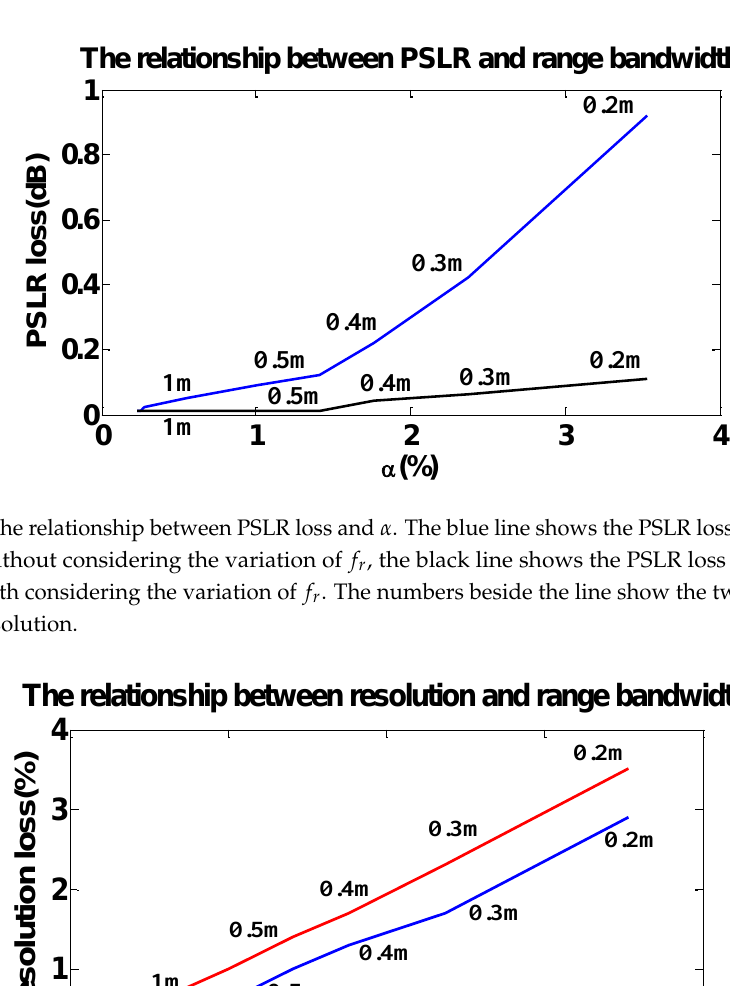
Figure 13. The relationship between resolution loss and α . The blue line shows the resolution loss in the azimuth direction without considering the variation of f r . The red line shows the theoretic resolution loss without considering the variation of f r . The black line shows the resolution loss with considering the variation of f r . The numbers beside the line show the two-dimensional theoretic resolution.